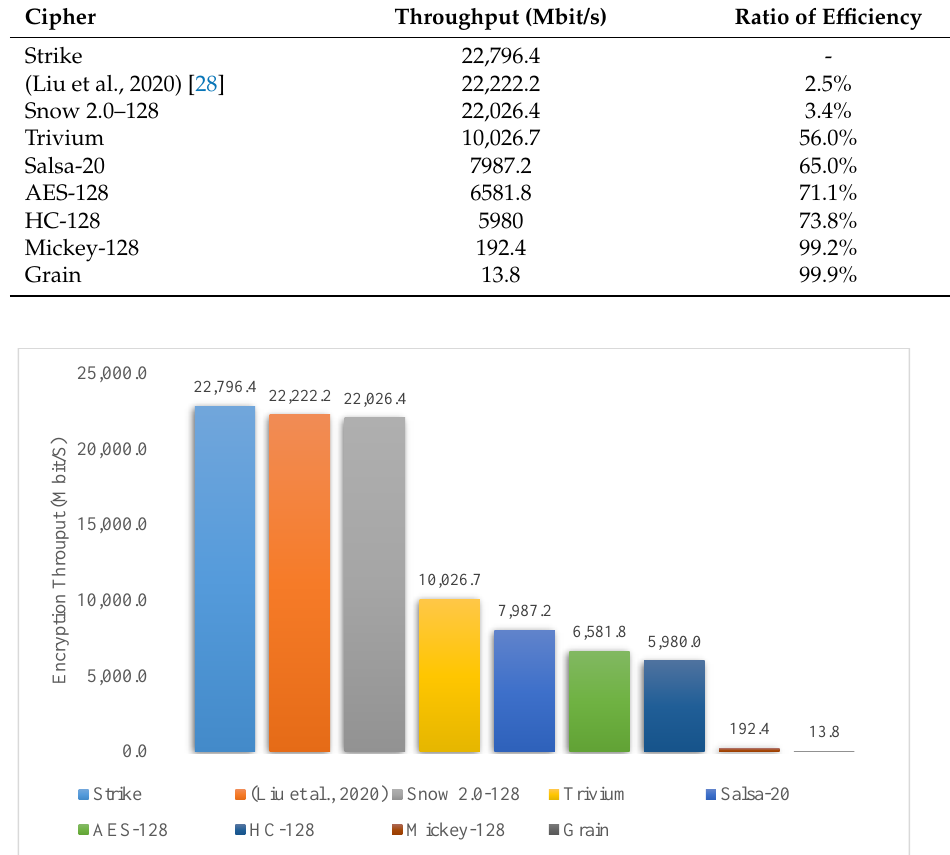
Figure 9. Stream ciphers throughput analysis on M1.